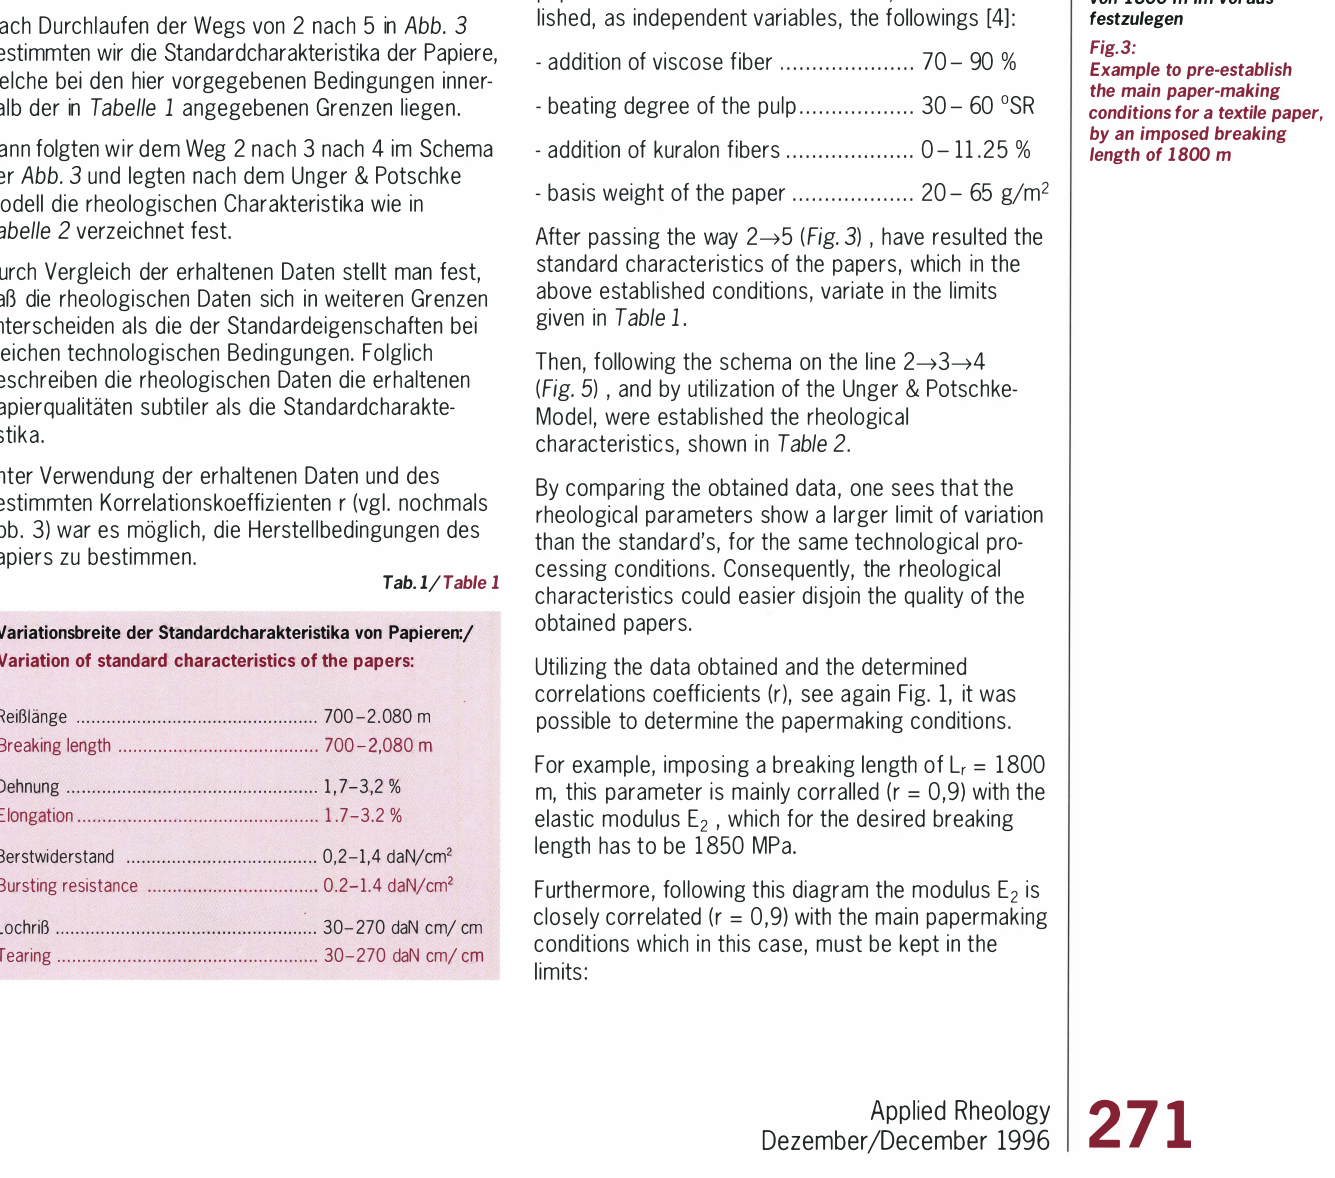
Fig.3: Example to